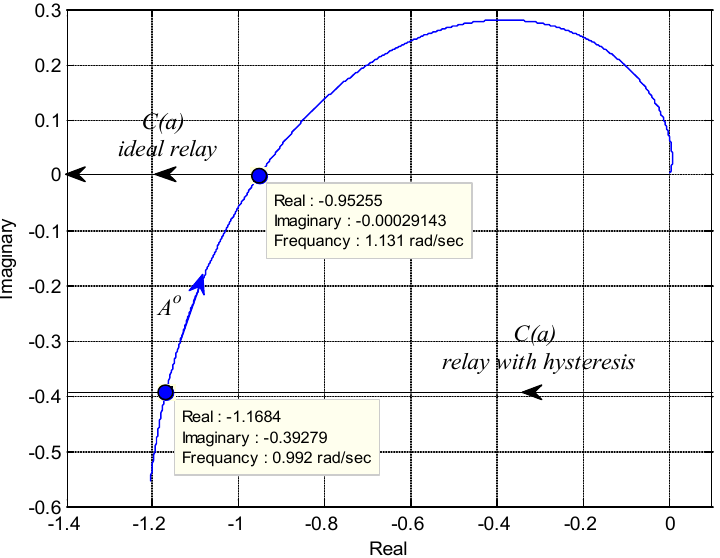
Figure 17. A Loci of